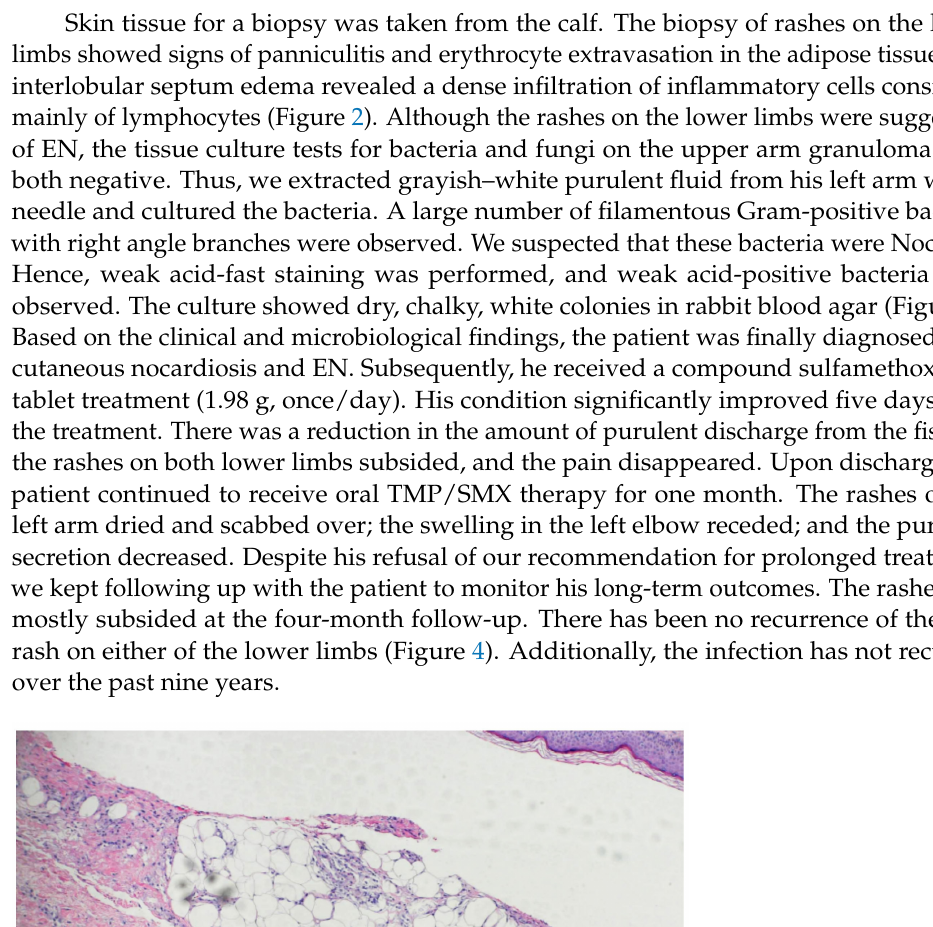
Figure 1. ( A ) Edematous plaques and fistulas on the left forearm ( B ) Erythematous nodules on both legs.